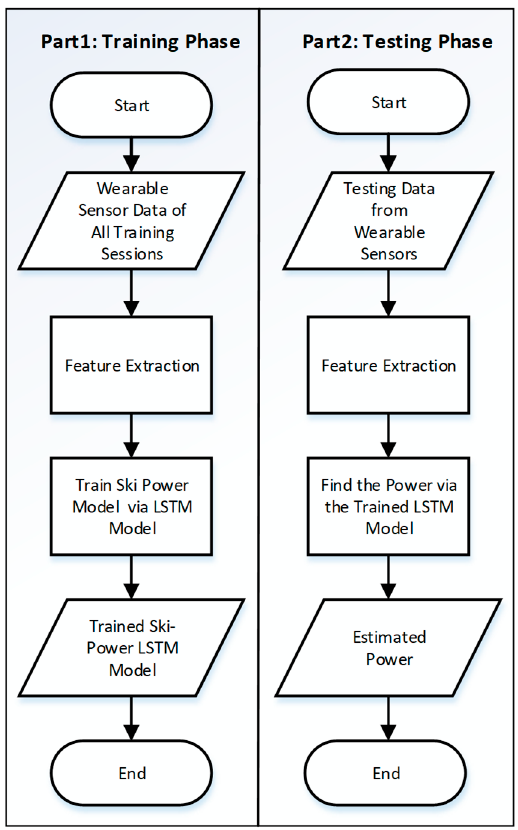
Figure 3. Flowchart of training and testing process of the proposed method.